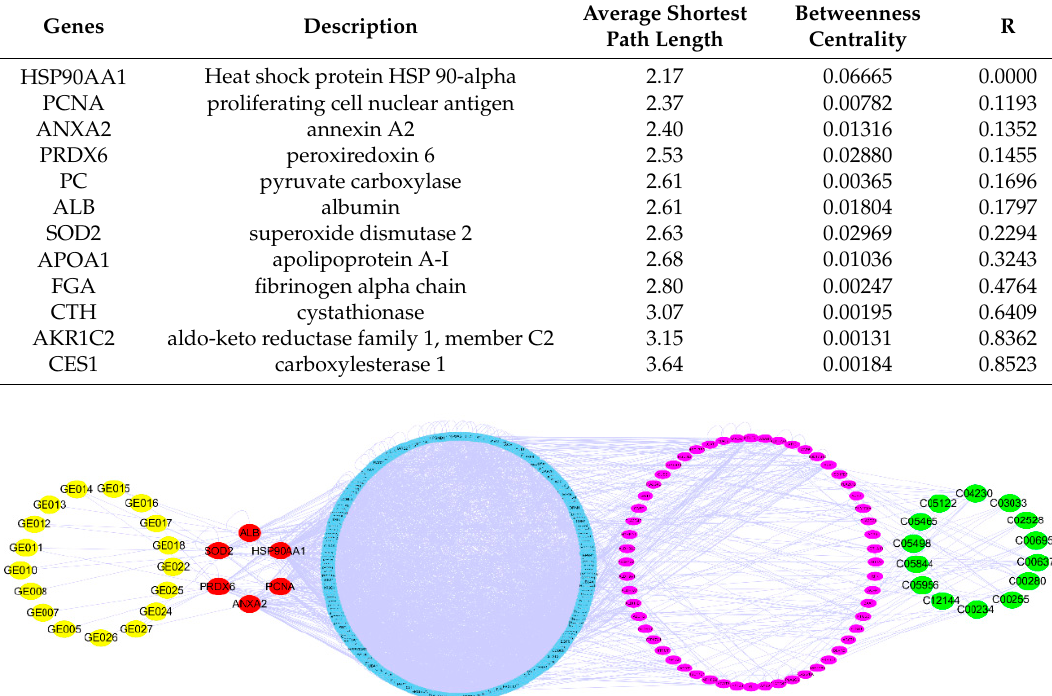
Figure 5. The crucial compound-target-metabolite network. The yellow, red, blue, pink and green nodes represent the active compounds, targets, adjacent proteins, pathway genes and potential metabolites, respectively. Table 2. Chemical information of compounds in V-kansui.